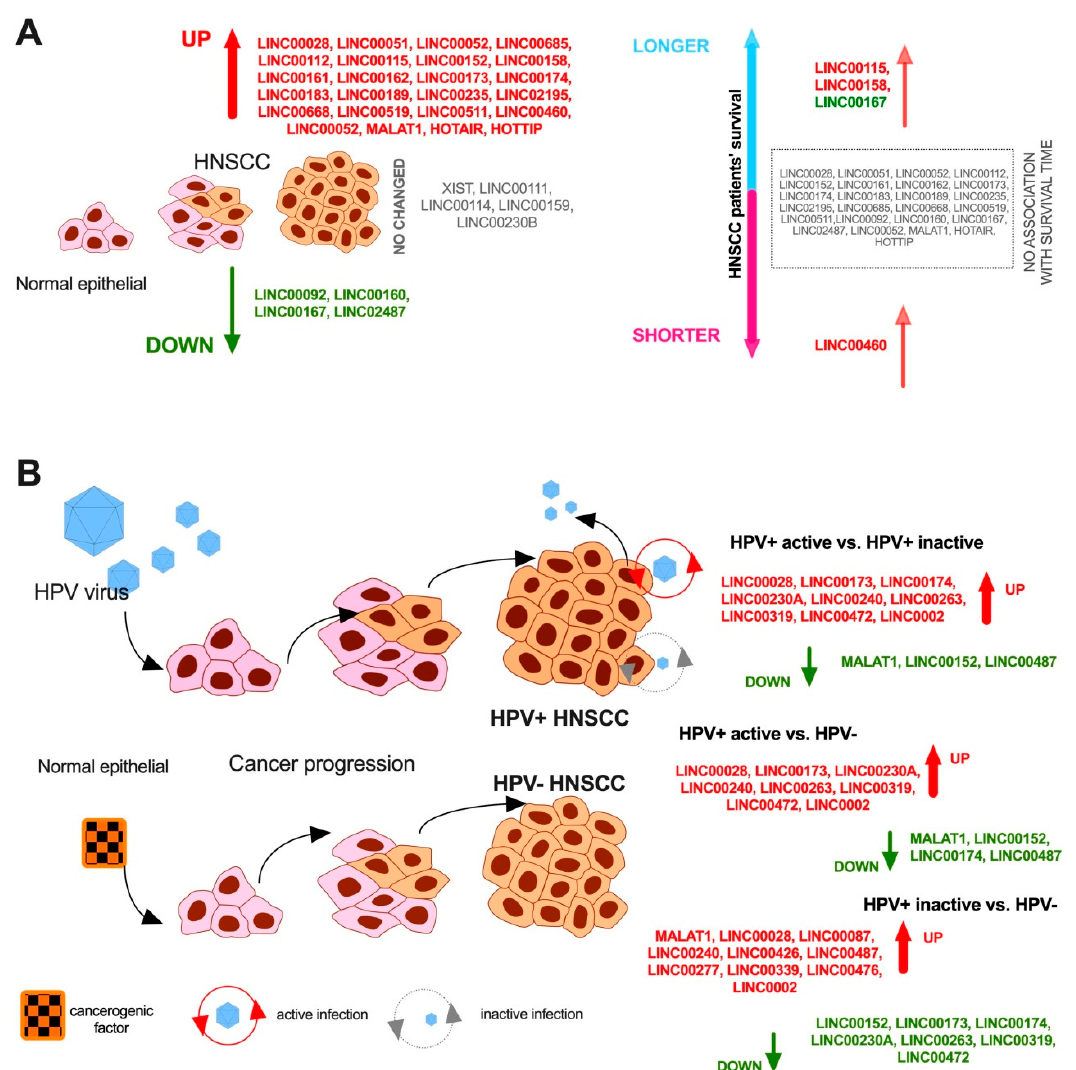
Figure 2. Changes in lincRNA expression levels in HNSCC patients based on ( A ) UALCAN database with differences in expression level between HNSCC samples and normal samples, and patients’ survival depending on the expression level of selected lincRNAs ( p <0.05 were considered statistically significant in the UALCAN results); ( B )HPV status based on Tomar’s results where 65 oropharyngeal samples including HPV+ and HPV − were analyzed using microarray analysis. The differences in the expression of lincRNA depending on HPV status as well as viral infection activities are listed [168].